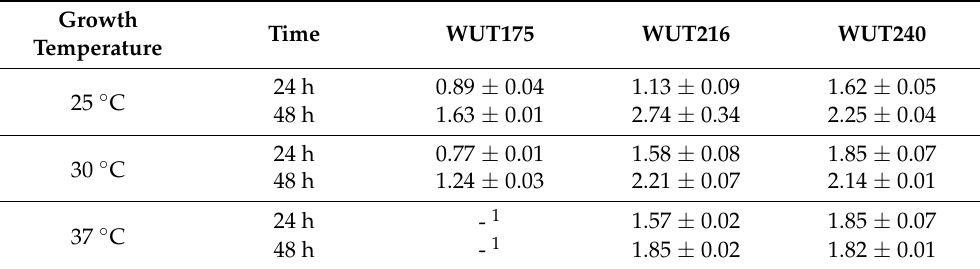
Table 1. 2-PE concentration [g L − 1 ] in batch cultures of K. lactis WUT175 and K. marxianus WUT216 and WUT240 strains conducted in medium 8 at 25, 30 or 37 °C for 48 h.